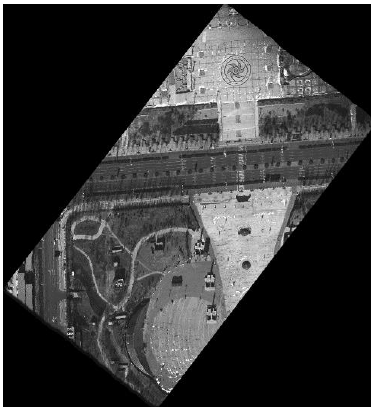
(a) Geometric rectification result